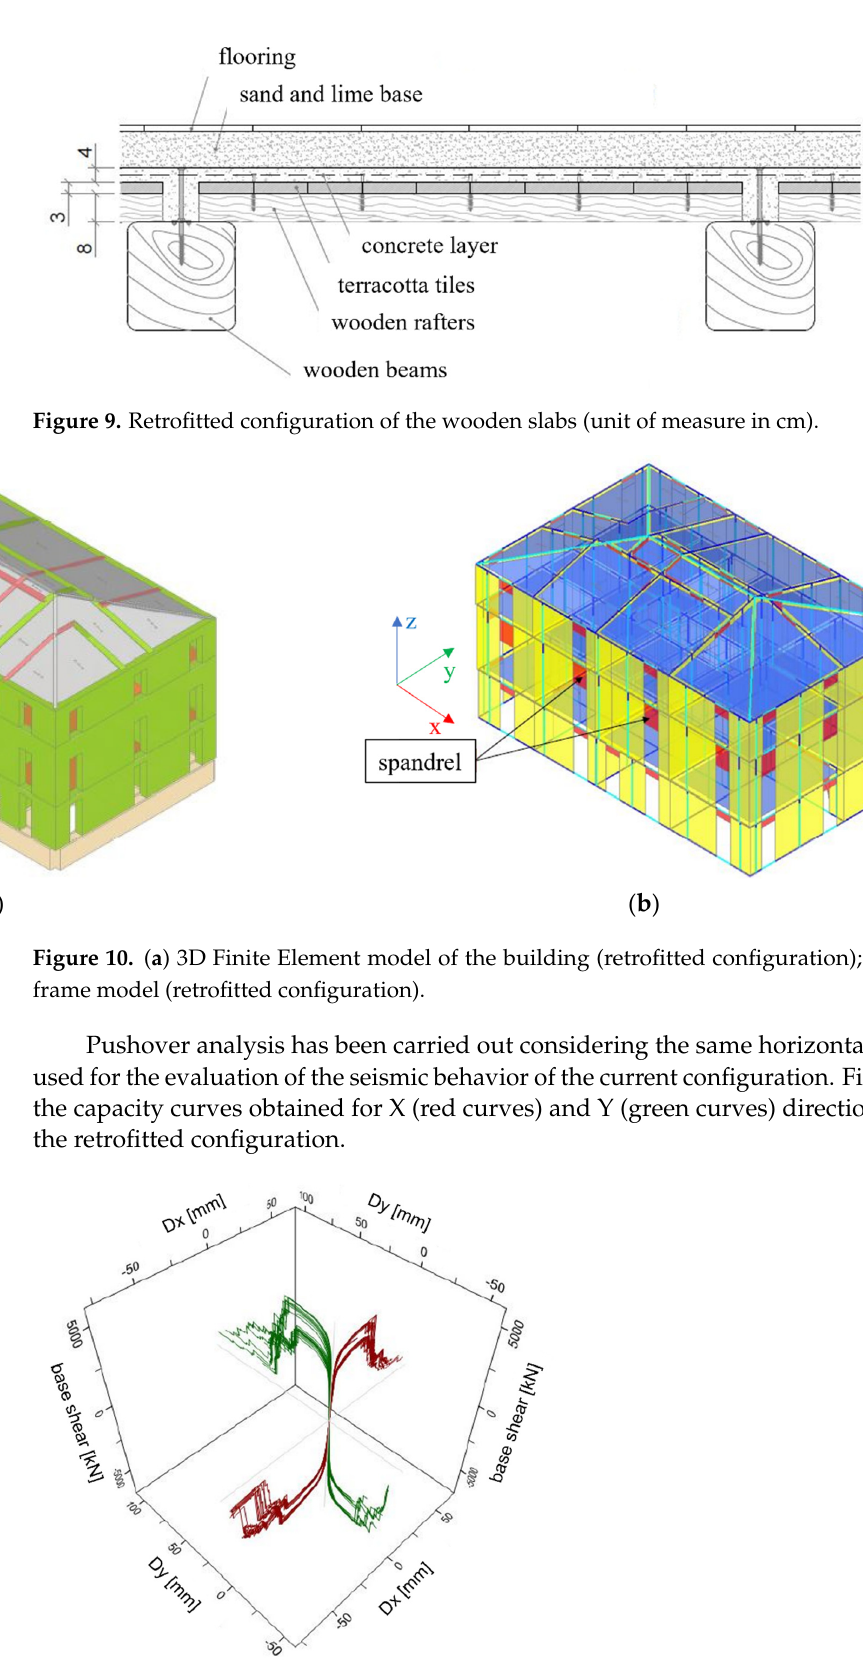
Figure 11. Capacity curves (retrofitted configuration).